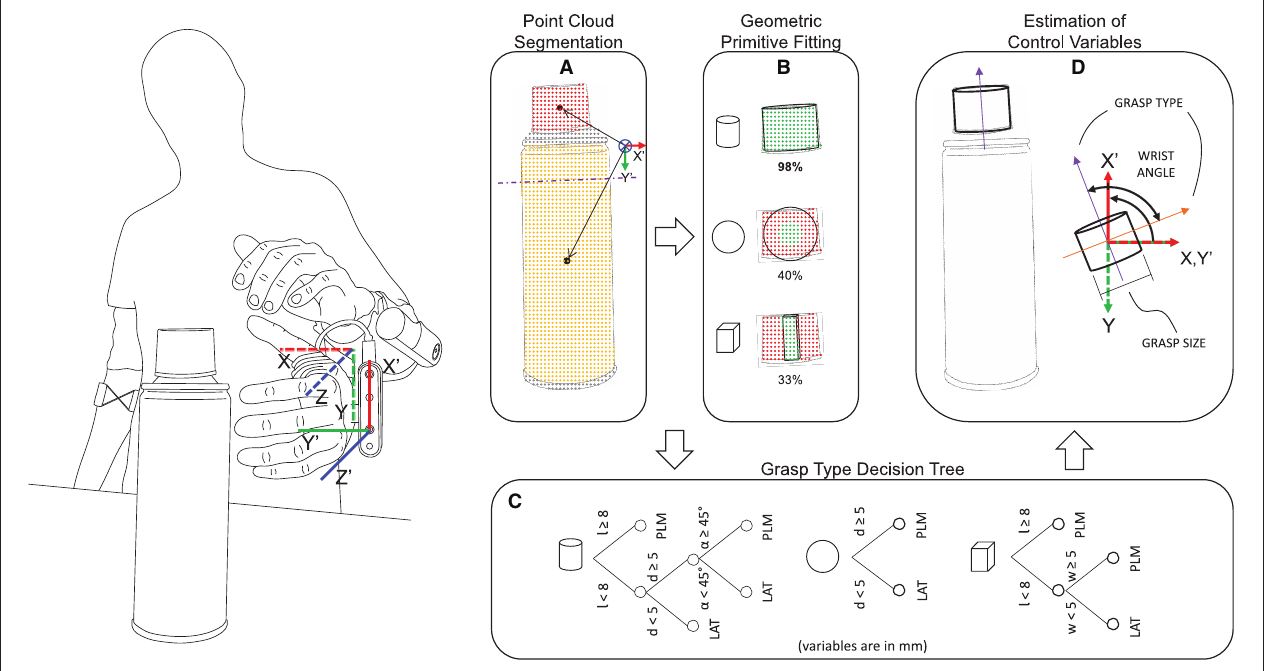
FIGURE 3 | Depth perception pipeline. The scene is segmented in the point clouds belonging to different objects/object parts and the partitioned point cloud with the closest centroid (A) is selected for shape fitting (B) . In the present example, the plastic cap is chosen as the target and the best model to fit the point cloud is the cylinder. The coordinate system of the camera (X’Y’Z’ frame, moving) and the socket (XYZ frame, static) is shown on the left. (A) Shows the projection of the point cloud centroids onto the X’OY’ plane of the camera, and the arrows represent the distance of the centroids from the origin of the camera coordinate system. (C) The decision tree for the selection of grasp type uses object properties such as length l , diameter d (or width w ) and approaching angle α (cylinder only), and enables selecting a palmar (PLM) or a lateral (LAT) grasp. (D) Derivation of the grasping direction vector from the model to calculate the orientation of the object in the static XYZ frame and the respective target wrist angle. The grasp size can be trivially obtained from the